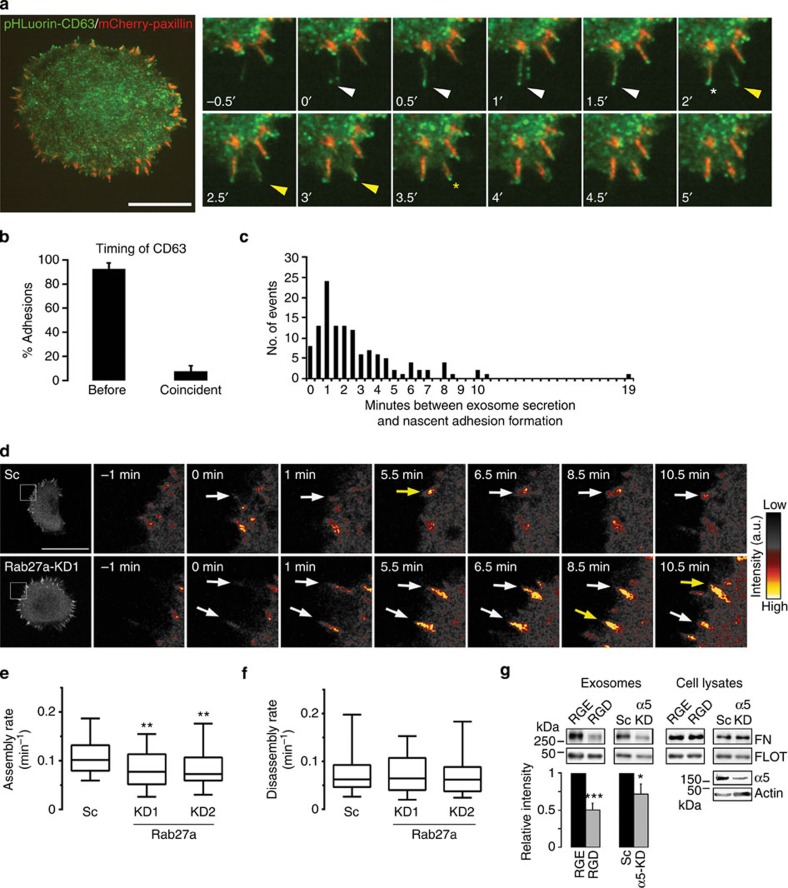
Exosomes promote adhesion assembly(a) Image from TIRF movie of pHLuorin-CD63 (green) and mCherry-paxillin (red)-expressing HT1080 cell on FN-coated (1 μg ml−1) MatTek dishes. Time series shows bursts of pHLuorin-CD63 fluorescence (arrowheads) preceding adhesion formation (indicated by *, red paxillin fluorescence visible at that time). Two adhesion formation events are, respectively, indicated with white and yellow markers. Representative of n=7 movies. See also Supplementary Movie 8. (b) Quantitation of per cent of adhesions with a pHLuorin-CD63 fluorescence burst before or coincident with their formation. (c) Quantitation of the number of minutes between pHLuorin-CD63 appearance and adhesion formation. (d) Representative time series of GFP-paxillin-marked adhesion assembly and disassembly for control (Sc) and Rab27a-KD HT1080 cells on FN-coated (1 μg ml−1) MatTek dishes. Magnifications of boxed area are shown at right by heat map coloration to show intensity. 0 min indicates start of adhesion formation. White arrows indicate example adhesions and yellow arrows indicate the peak adhesion intensity. Asterisk indicates a newly forming adhesion. Note that a longer period of time is required for adhesion assembly in KD cells. (e,f) Box-and-whisker plots of adhesion assembly (e) and disassembly (f) rates. Each box shows the 25–75th percentile and whiskers indicate the 5–95th percentile and the black line indicates the median. Analysis from >30 adhesions for e and >40 adhesions for f from three to eight cells per condition. See also Supplementary Movie 9. (g) Western blot analysis of FN association with exosomes. GRGESP (100 μM; RGE, control) or GRGDSP (100 μM; RGD, integrin-binding) peptides were added to cultured HT1080 control cells (Sc) for 48 h before exosome isolation. Equal exosome numbers were loaded on western blots. Quantitations show FN intensity normalized to flotillin intensity as a loading control from n≥4 western blots. α5-KD, integrin α5-knockdown-HT1080. *P<0.05; **P<0.01; ***P<0.001 compared with Sc using Mann–Whitney U-test. Scale bars in a and d represent 30 μm.